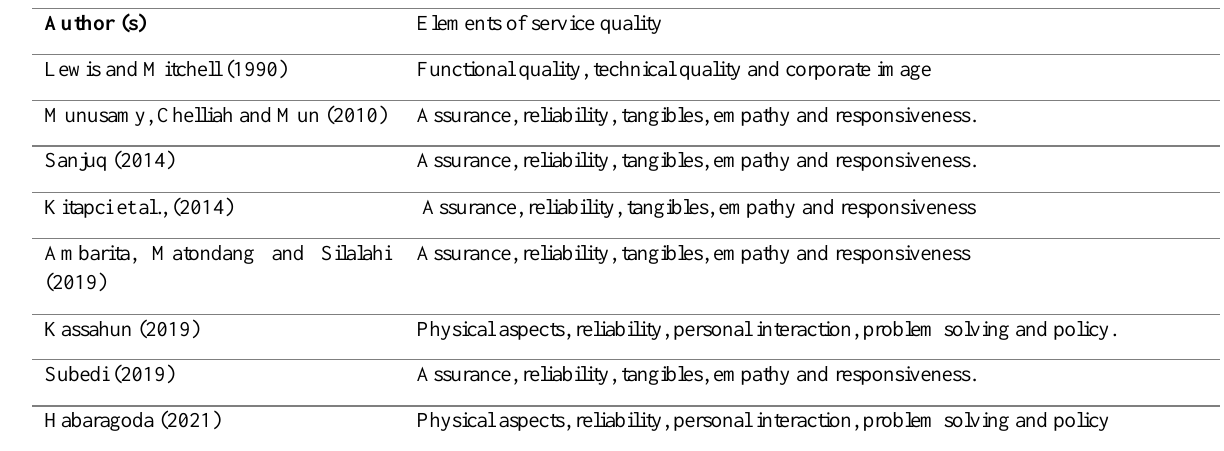
Table 1: Elements of Service